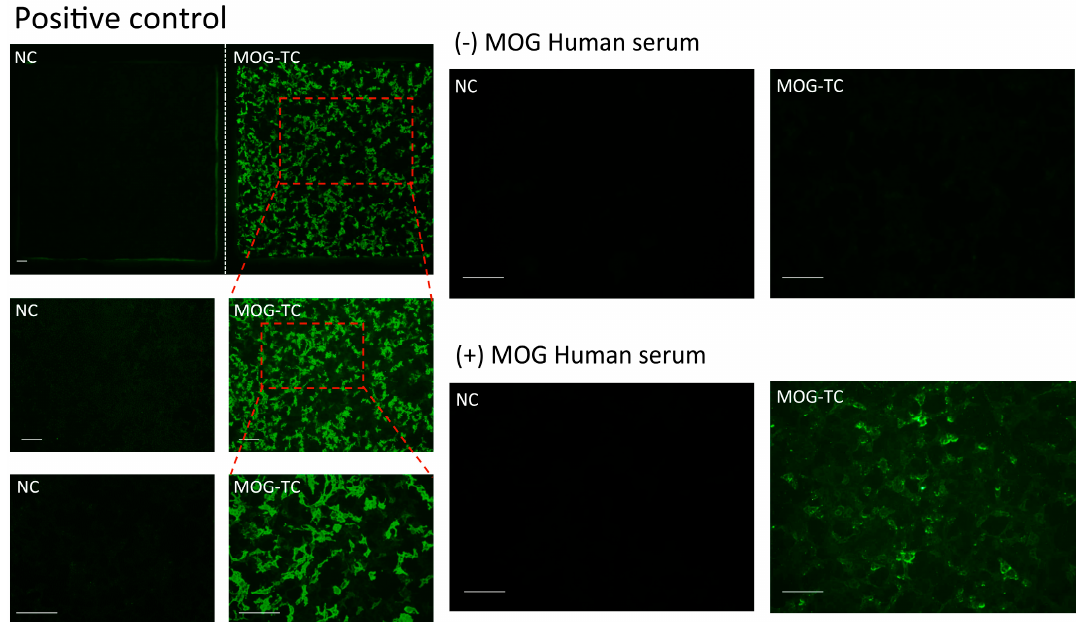
Figure 2. Immunofluorescence assay for the detection of anti-MOG antibodies. Representative images of the Euroimmun kit using patient serum and positive control serum over either MOG expressing cells (MOG-TC) or nor MOG expressing cells (NC) as negative control. The immune reaction produced by patient serums with anti-MOG antibodies were visualized in green. Scale bar 100